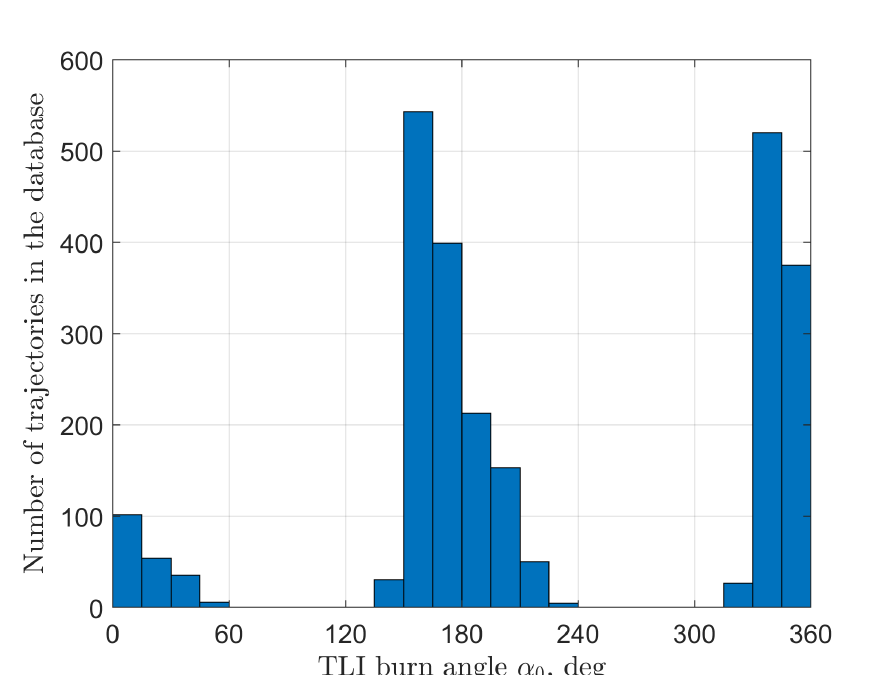
Figure 17. Distribution of spacecraft polar angle values at the moment of TLI burn execution for SALT trajectories without an intermediate lunar flyby. Two peaks at about 160 deg and 340 deg correspond to the 4th and 2nd quadrant trajectories. The pattern is repeated almost exactly when shifting by 180 deg.